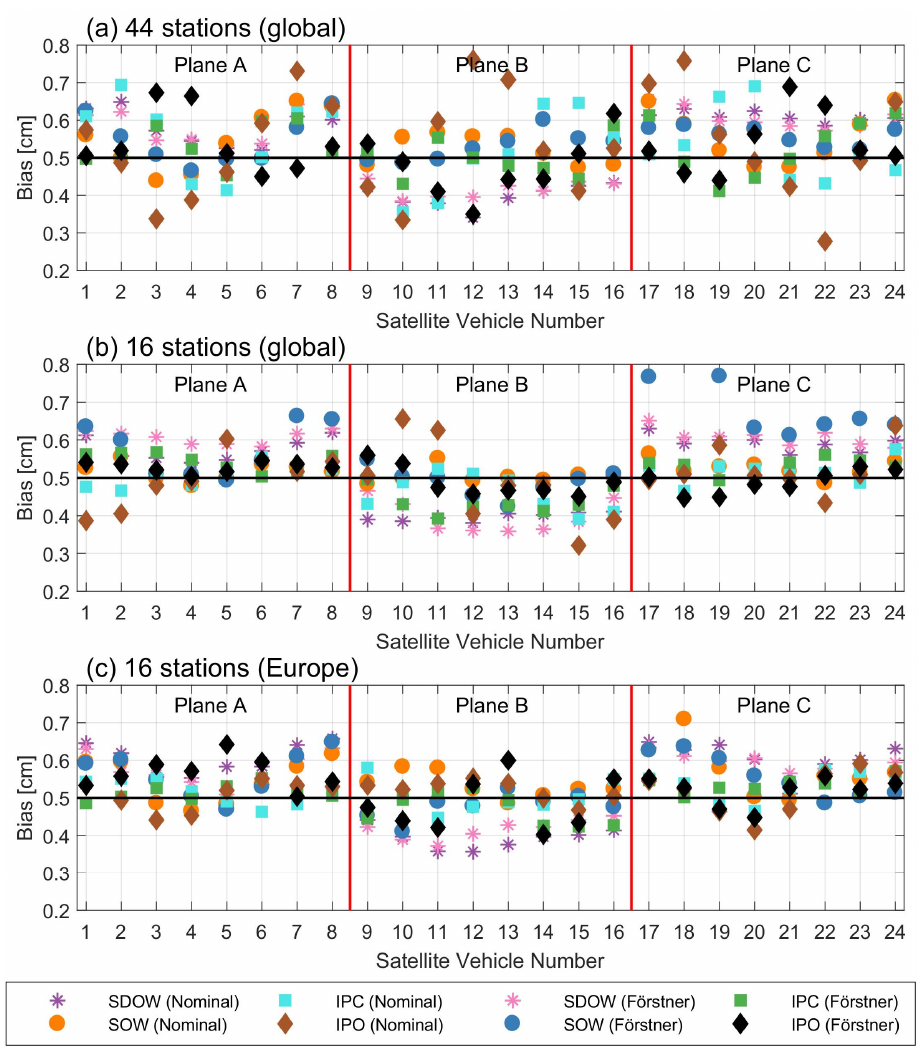
Figure A1. Mean estimated ISL range biases of each satellite (simulated value of 0.5 cm) for different ground station sets: ( a ) 44 stations (global), ( b ) 16 stations (global), and ( c ) 16 stations (Europe) under different weighting methods.